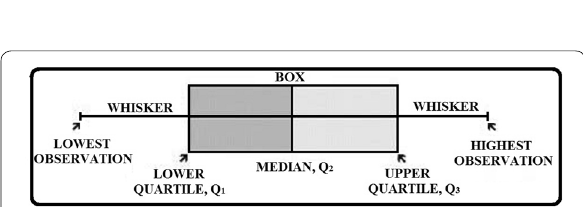
Fig. 4 The box and whiskers (Modified after Interworks 2017)